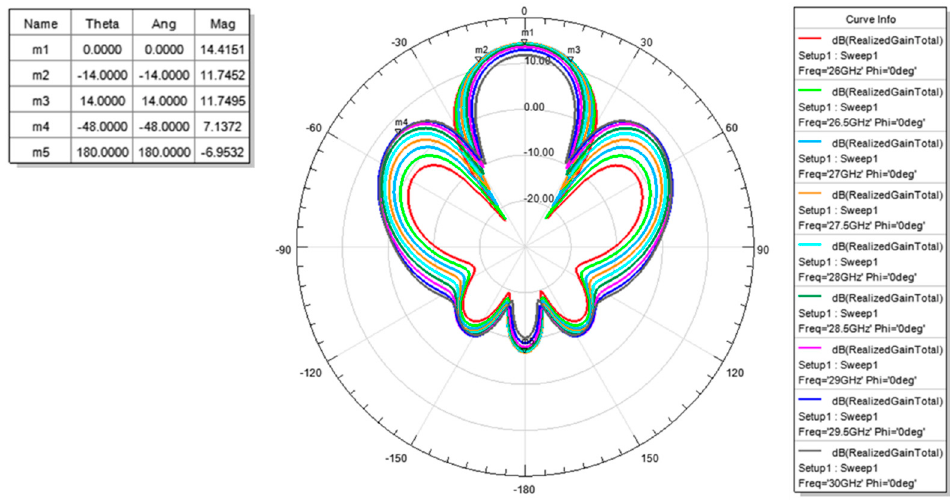
Figure 8. Radiation pattern of the simulation (X Cut).